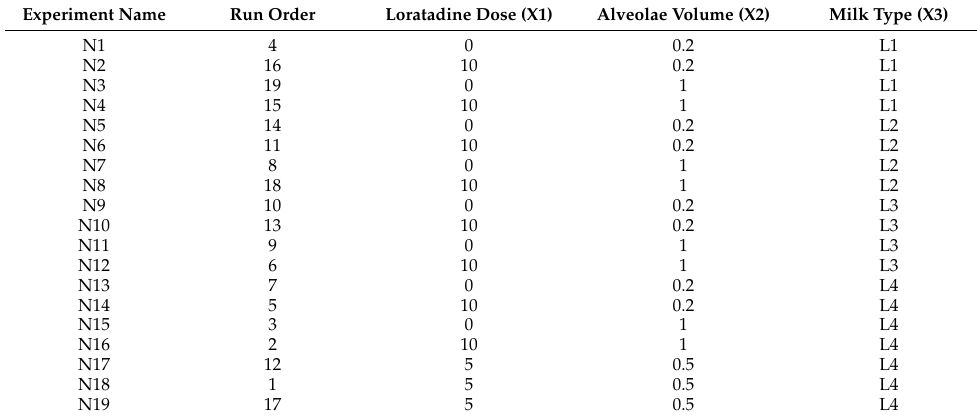
Table 2. Design of experiments